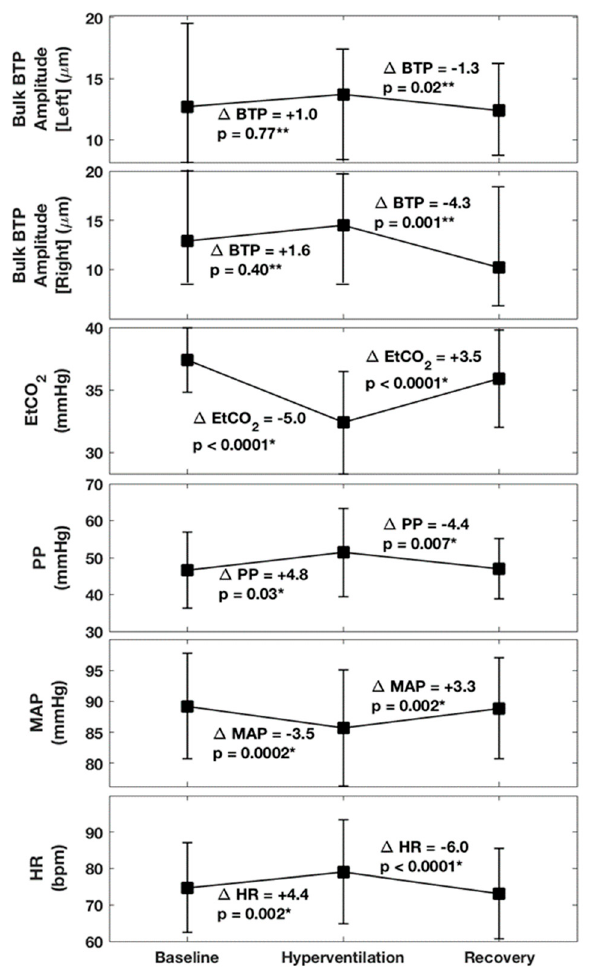
Figure 3. Summary of changes observed between baseline, hyperventilation, and recovery in 30 volunteers. Bulk BTP amplitude is expressed as median and IQR values, with all other variables described by their mean and standard deviation. Estimated differences between baseline and hyperventilation, and between hyperventilation and recovery, are labelled in the figure. Paired t-tests * and Wilcoxon signed-rank test ** were carried out to determine whether changes were statistically significant at a p-value of p = 0.05. For 95% For confidence limits, please see the values reported in the text. (Note that adjustment for multiple comparisons using a Bonferroni correction suggests an adjusted p -value of p = 0.004 as a more conservative threshold for